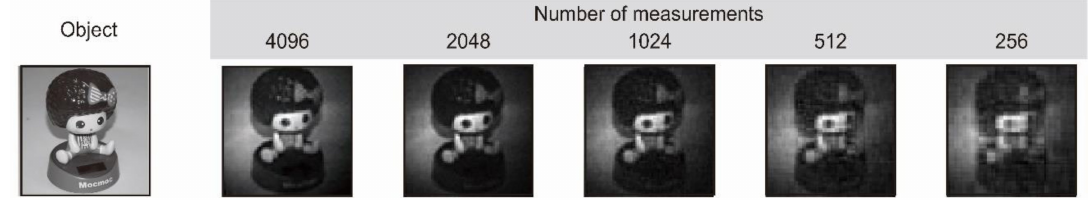
Figure 2. Single-pixel imaging reconstructions (64 × 64 pixel resolution) using experimental data with different numbers of